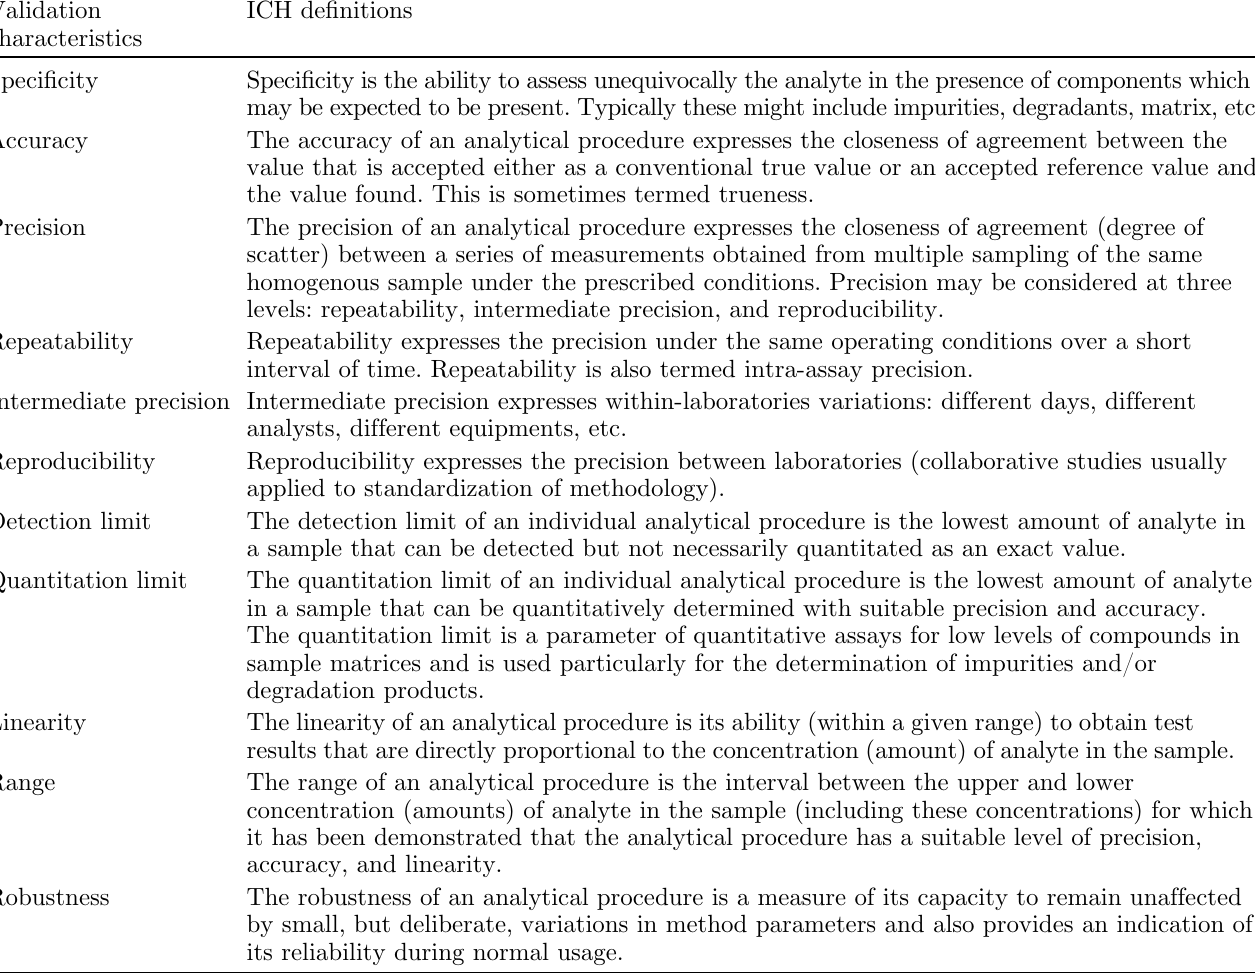
Table 1. Performance criteria for analytical method validation.